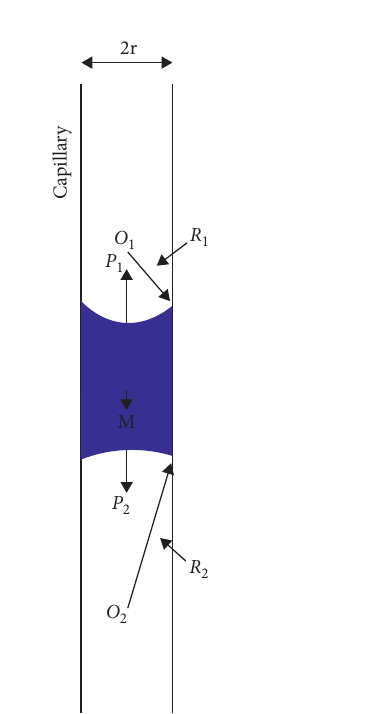
Figure 13: Curves of the average water content of 90 cm thick soil varying with time.